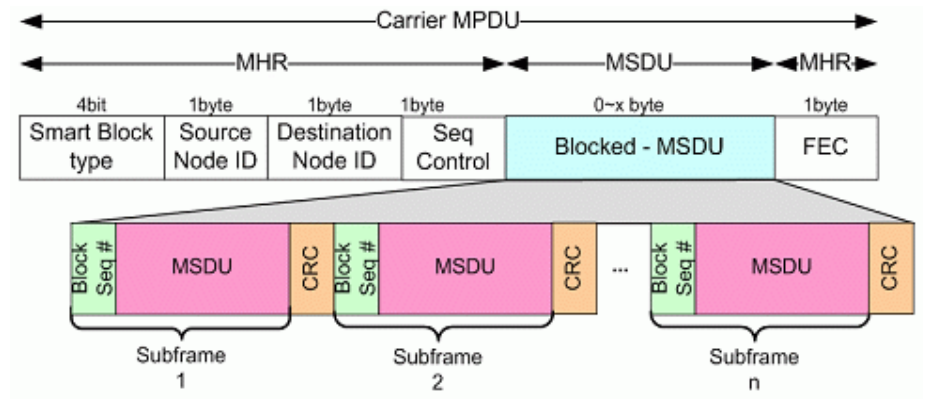
Figure 7. Blocked Data Frame format (Required Block